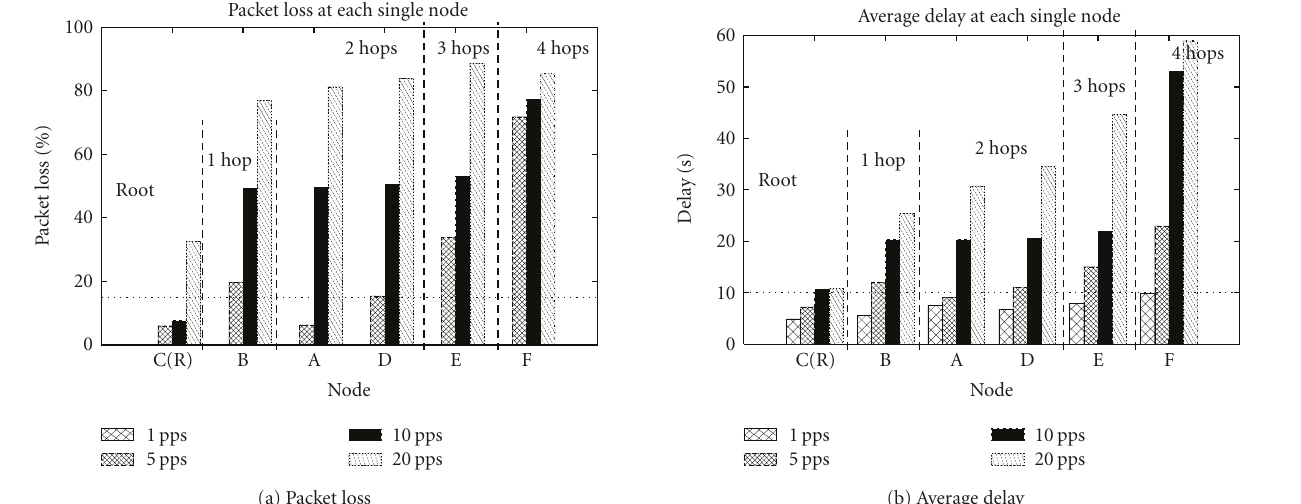
Figure 7: Single-node